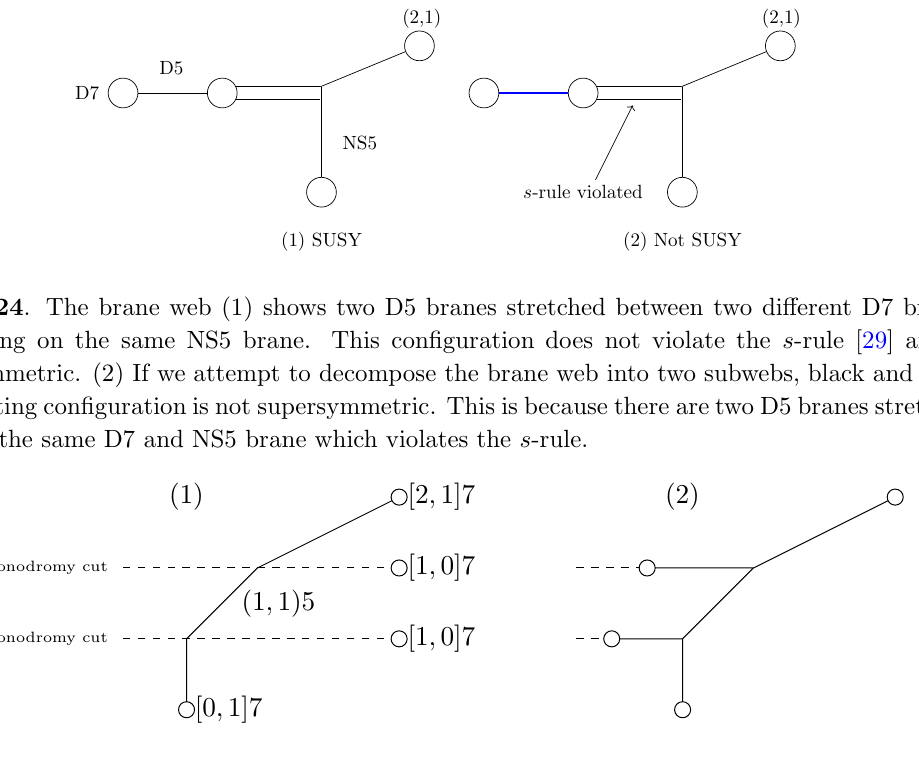
Figure 25 . Shown is an example similar to the one in figure 24. (1) The monodromy cut of the D7 branes turns the (2 , 1)5-brane into a (1 , 1)5-brane and (0 , 1)5-brane respectively. (2) The same system after Hanany-Witten transition. If the D7 branes are brought together on the same horizontal axis one gets back the example in figure